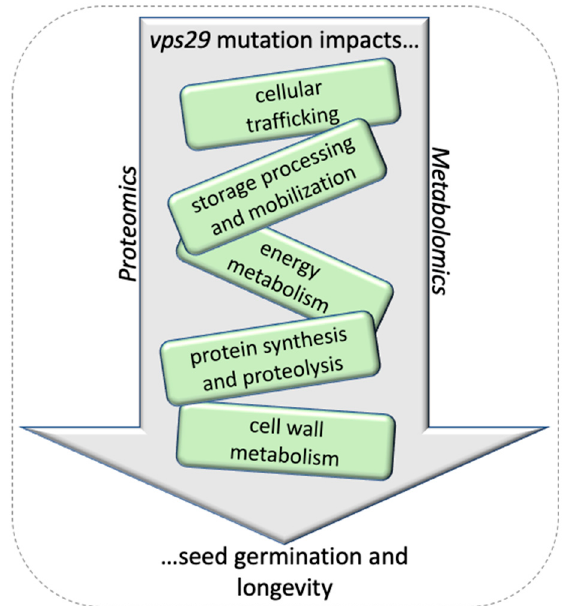
Figure 5. Schematic diagram illustrating the main e ff ects related to vps29 mutation in Arabidopsis thaliana seeds highlighted by proteomics and metabolomics.